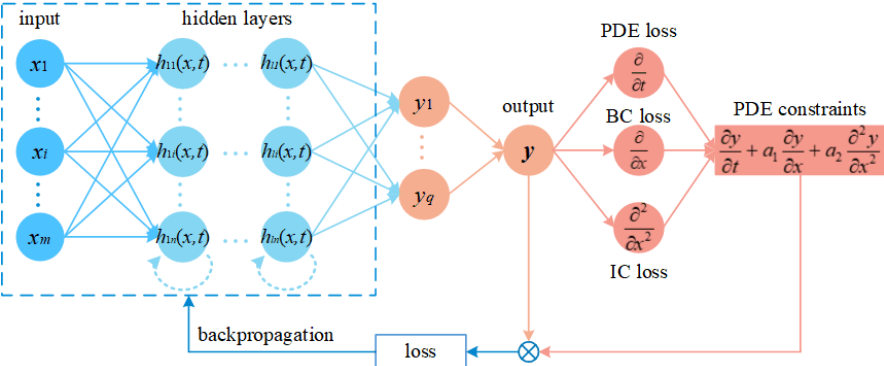
Figure 3. PDE constraints for the ML algorithm to achieve